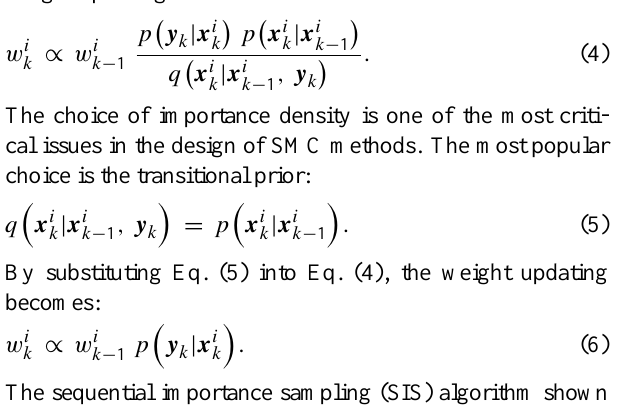
Carlo methods can be found in Arulampalam et al. (2002) and Moradkhani et al.